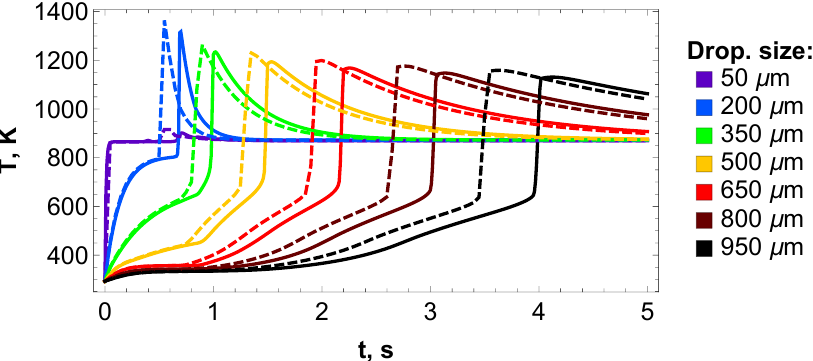
Figure 6. The surface temperature dynamics for aerosol particles with different size. The solid lines correspond to the CWS and the dashed to the